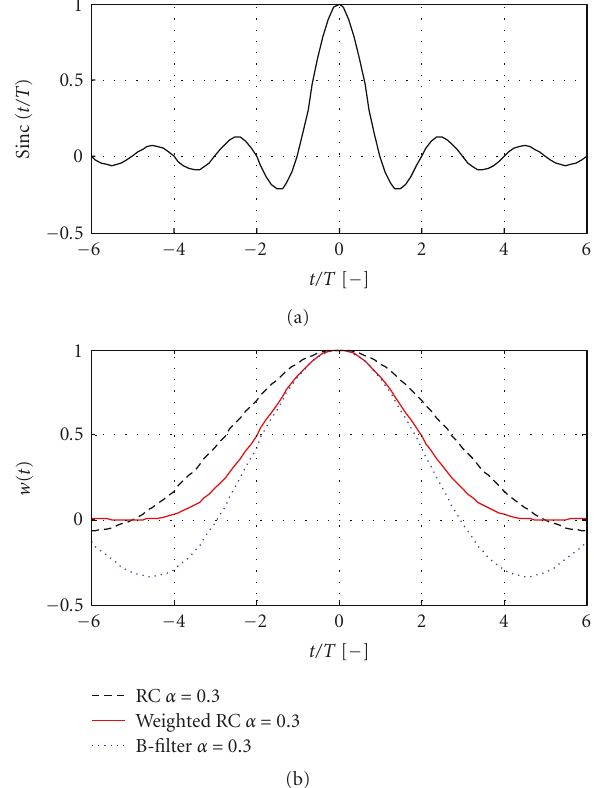
Figure 1: Decomposition of the modulation filters impulse responses. (a) Sinc( t/T ) function, the ideal Nyquist filter. (b) Typical windowing functions used to limit its impulse response.